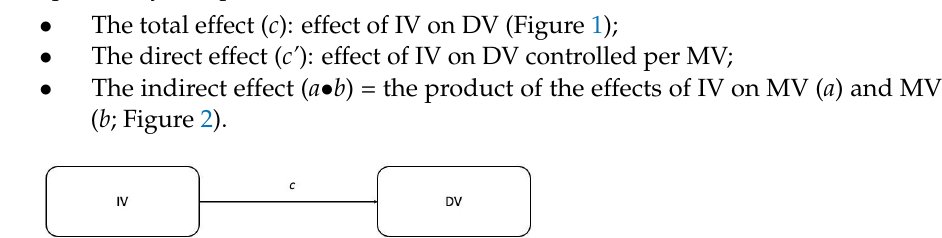
Figure 1. Model without the mediation variable; c = total effect.